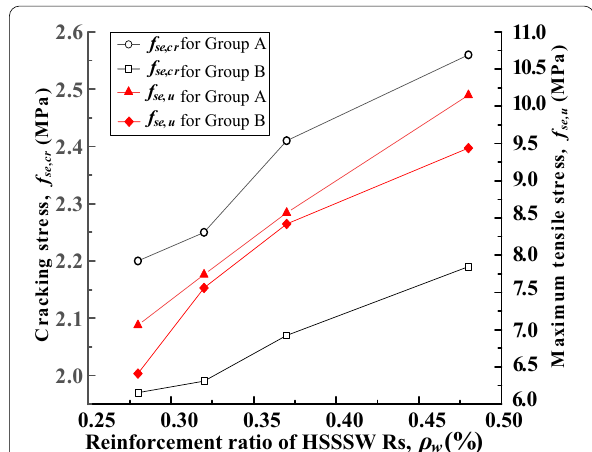
Fig. 7 Effects of the reinforcement ratio of HSSSWRs on cracking stress and maximum tensile